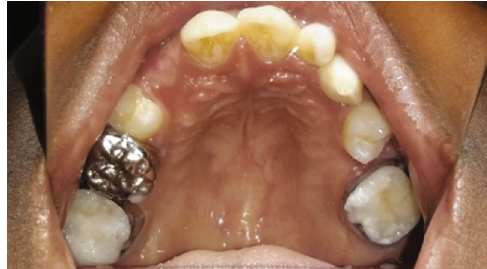
Figure 7: Intraoral photograph showing cemented palatal button on rotated 13 and 24.